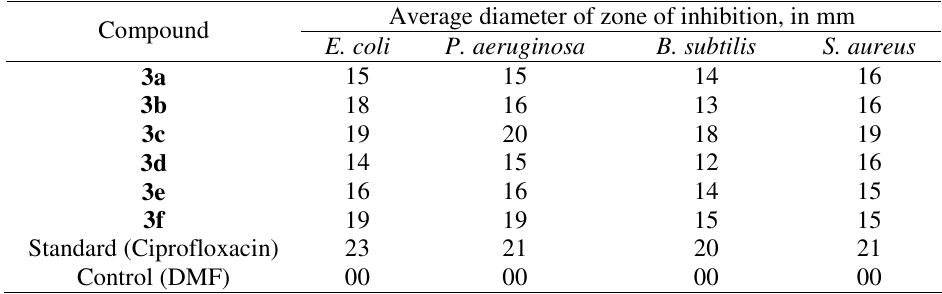
Table 3. Antibacterial screening data of compounds